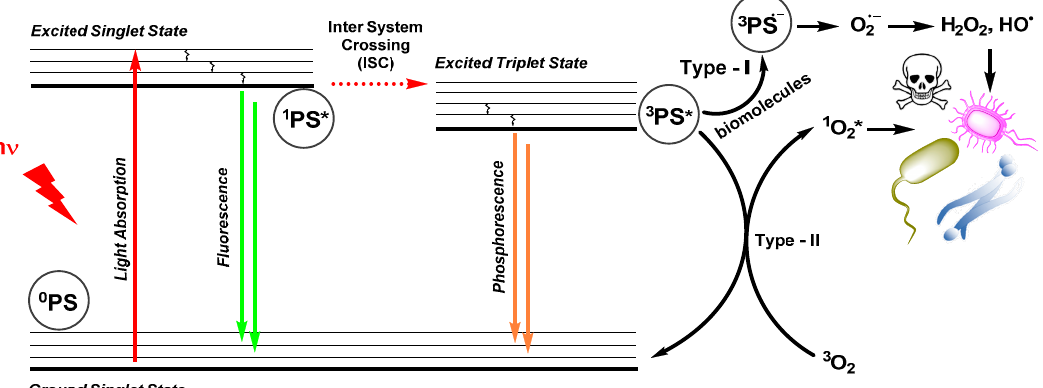
Figure 1. Simplified Jabło´nski diagram showing the generation of reactive oxygen species (ROS) by a photosensitizer (PS) following absorption of light, intersystem crossing and Type-I and -II mechanisms. In antimicrobial photodynamic therapy (aPDT), the resulting ROS are able to kill bacteria and fungi as illustrated on the